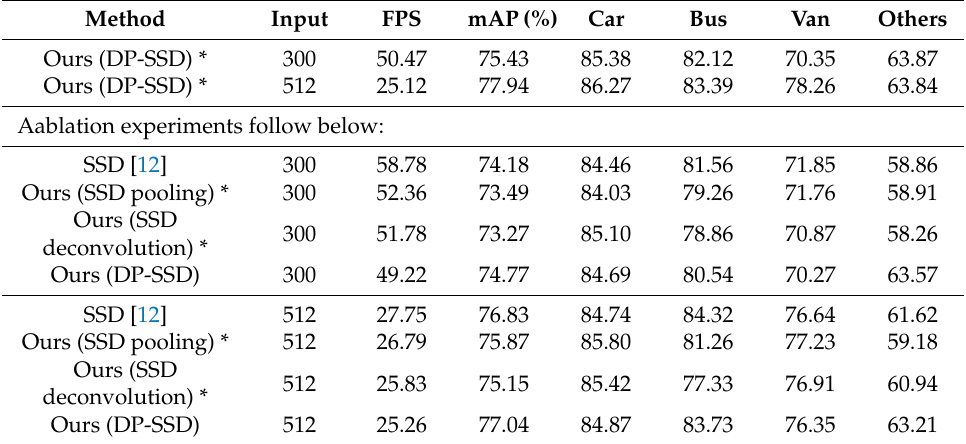
Table 4. Detection results on UA-DETRAC test set (trained on UA-DETRAC trainval dataset in this paper). The input size is 300 or 512, but using various detectors for training and testing. * denotes using the new default box size in Table 2 or Table 3.